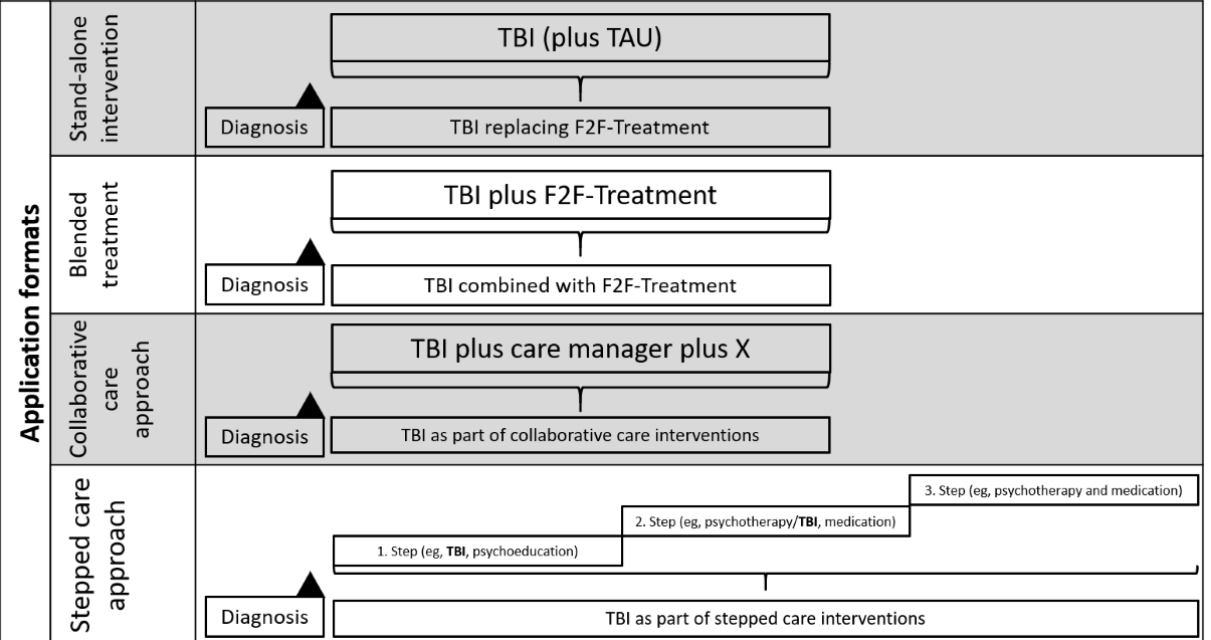
Figure 1. Illustration of potential application formats of technology-based psychological